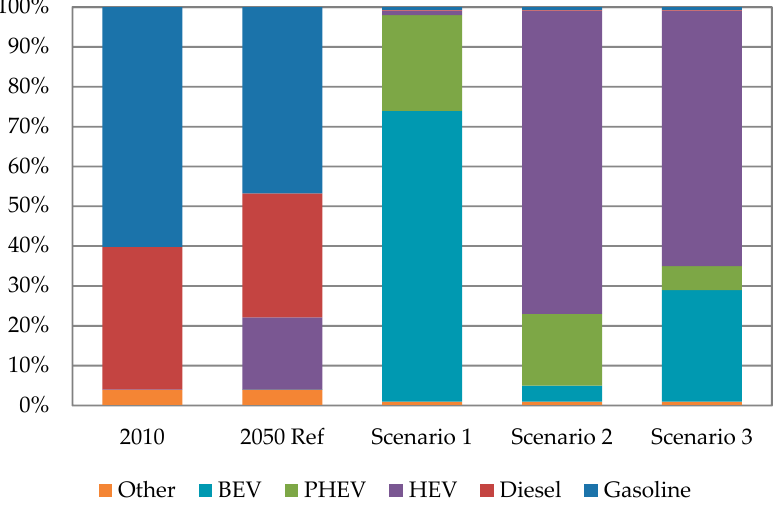
Figure 2. Car fleet composition, by vehicle Figure 2 . Car fleet composition, by vehicle type.